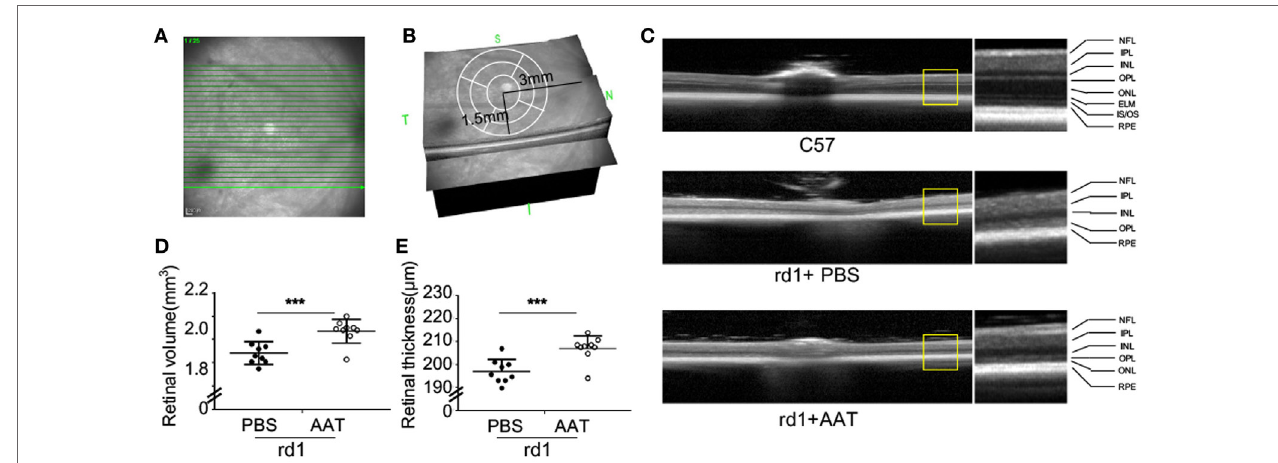
FigUre 2 | Alpha-1 antitrypsin (AAT) reduced retinal degeneration in rd1 mice. (a) The scanning model used in the study. Twenty-five linear scans within 6 × 3 mm 2 area adjacent to optic nerve disk were obtained at nasal and temporal retinae. (B) The average retinal thickness was measured in circle area with a radius of 1.5 mm, centering at 3 mm away from optic nerve disk. (c) The retinal structure was well-organized with multiple layers in the C57 mice ( n = 6), while the layers of ONL, ELM, and IS/OS junction were poorly visible in the PBS-treated rd1 mice at P16. However, the AAT-treated rd1 displayed a visible low-reflecting ONL layer. Abbreviations: NFL, nerve fiber layer; IPL, inner plexiform layer; INL, inner nuclear layer; OPL, outer plexiform layer; ONL, outer nuclear layer; ELM, external limiting membrane; IS/OS, inner segment/outer segment; RPE, retinal pigment epithelium. The retinal volume (D) and thickness (e) were increased in the AAT-treated rd1 mice compared to PBS-treated ones. n = 9 mice for each group. *** p < 0.001 (two-tailed unpaired t